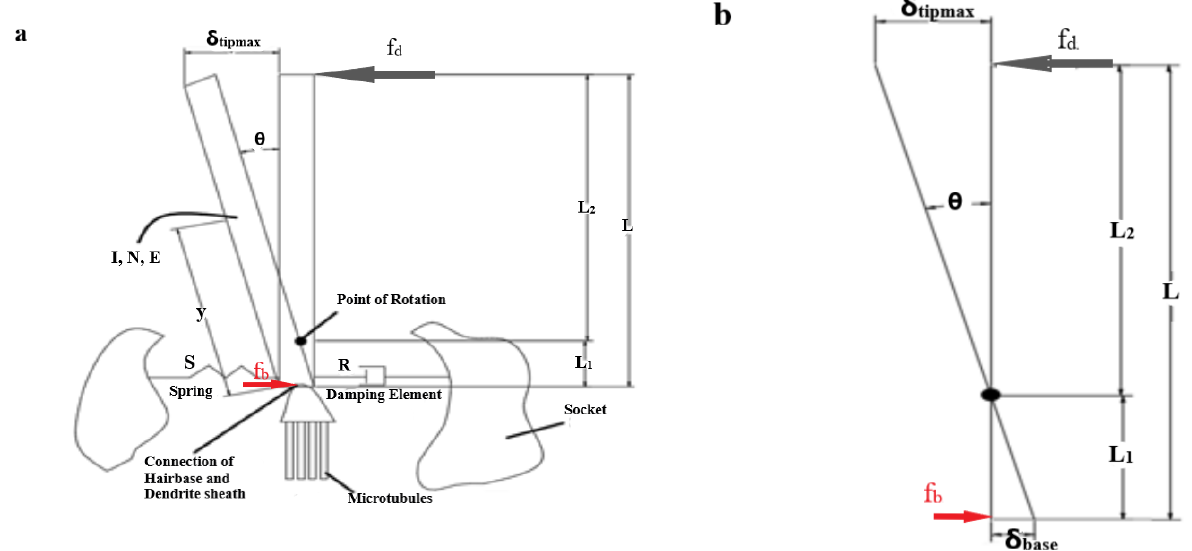
Figure 1. Inverted Pendulum Model. ( a ) Sensilla model as an inverted pendulum. ( b ) The mechanical schematic of sensilla. Θ is the deflection angle, f d is the point load applied at a distal end, fb is the force developed at the hair base due to the distal deflection on the hair shaft, the torsional restoring element S represented by a spring, the torsional damping element R by a dashpot, I is the moment of inertia, N is the torque applied, L is the length of the hair shaft, L 1 is the length of the hair shaft below the pivot point, L 2 is the length of the hair shaft above the pivot point, δ tipmax is the distal deflection, and δ base is the basal deflection.